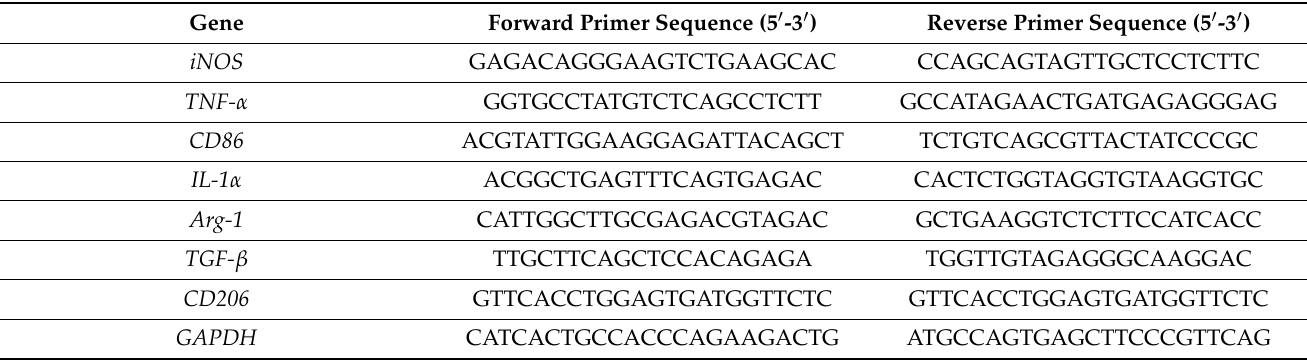
Table 1. Primer sequences of the differentiation